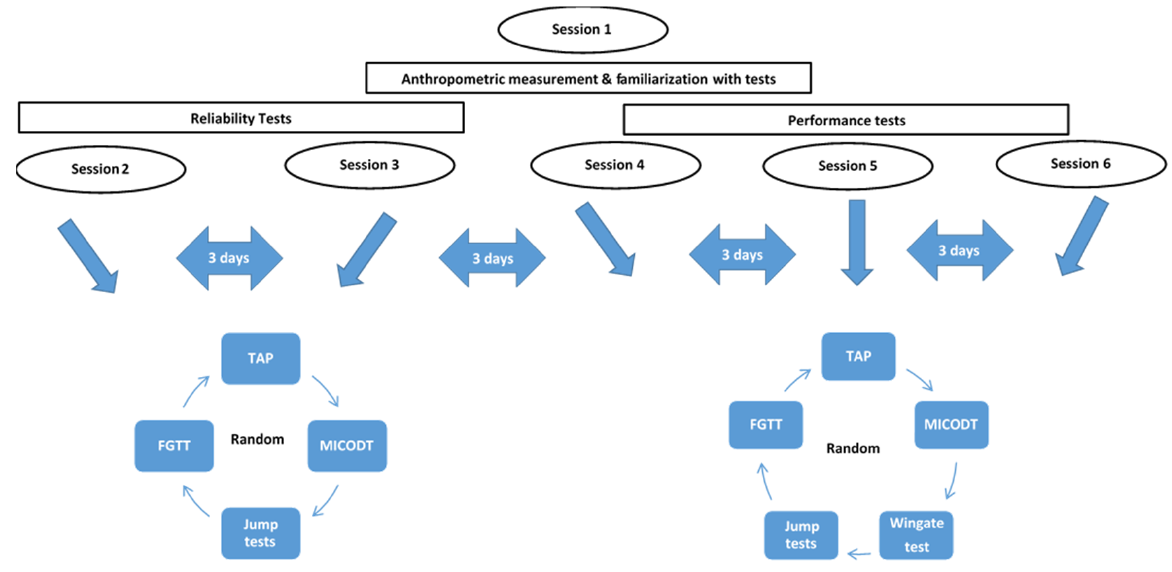
Figure 1. Schematic diagram of experiment.